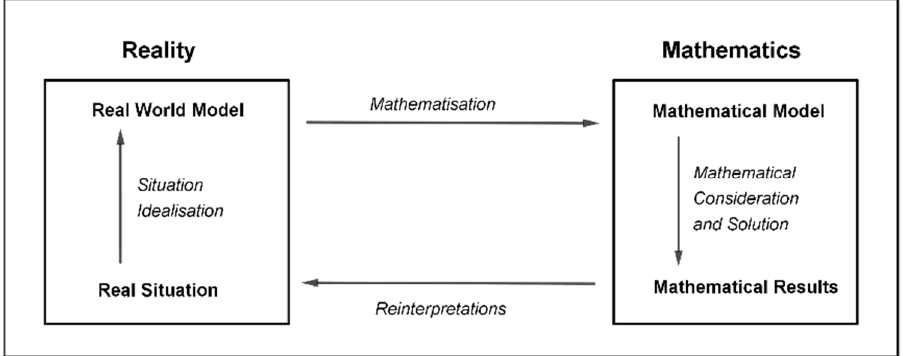
Figure 2. Kaiser’s modeling cycle (source: adopted from [6]).